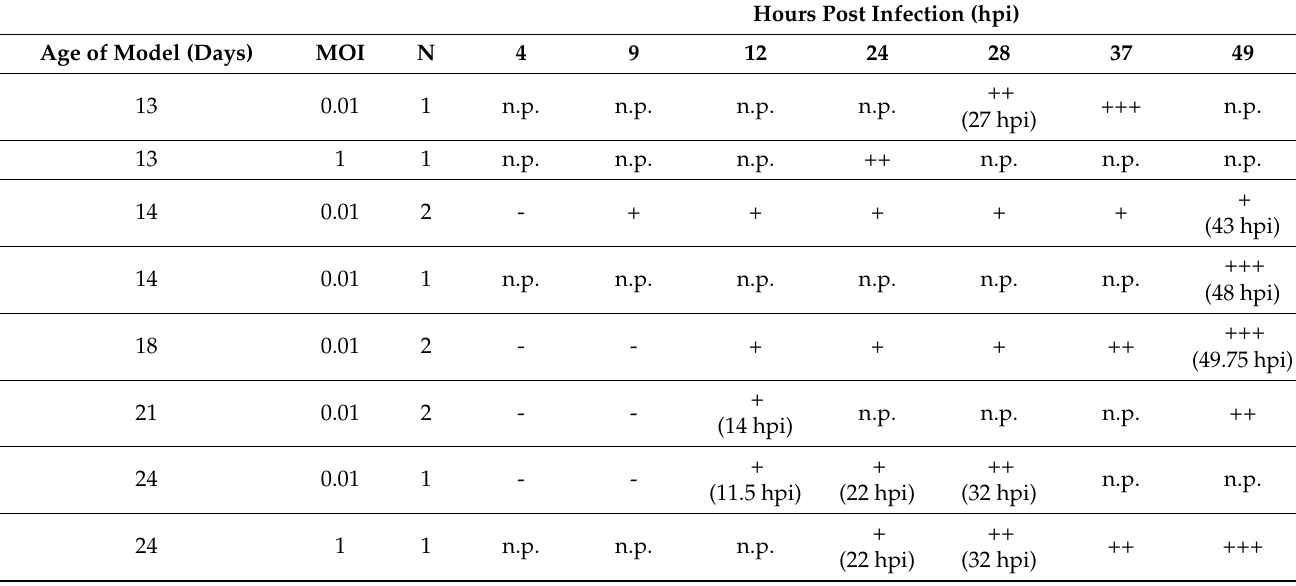
Table 1. Summary of infection experiments in submerged models. Hours Post Infection